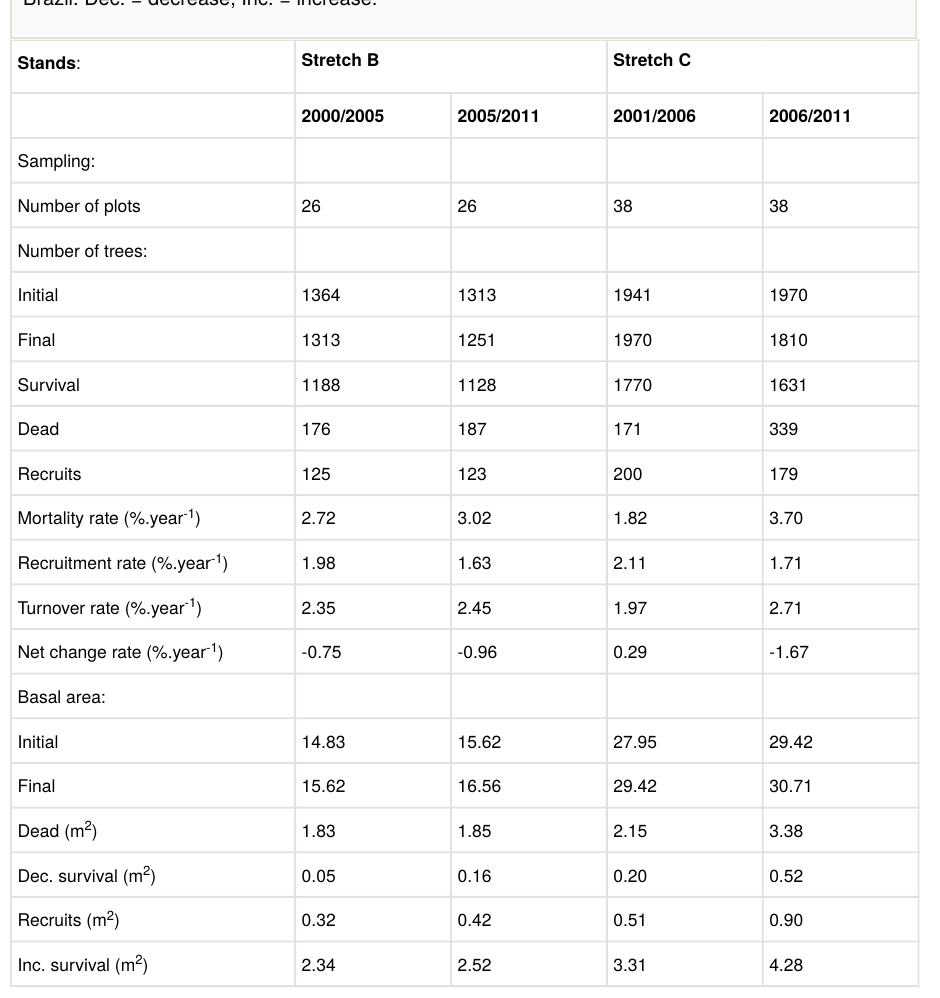
Table 3. The dynamic tree components of two stands (B and C) in a Semi-deciduous Forest in the Parque Ecológico Quedas do Rio Bonito, municipality of Lavras, South of Minas Gerais State, Southeast Brazil. Dec. = decrease; Inc. =